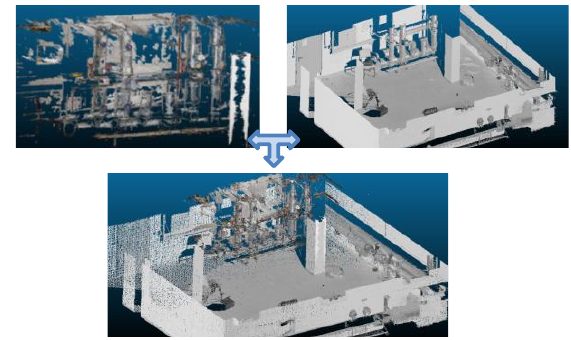
Figure 11: The entire point cloud of the experimental room including TLS point cloud and SfM-based point cloud after transformation. Colorized point cloud is generated from SfM, and TLS point cloud is shown with grey colour.